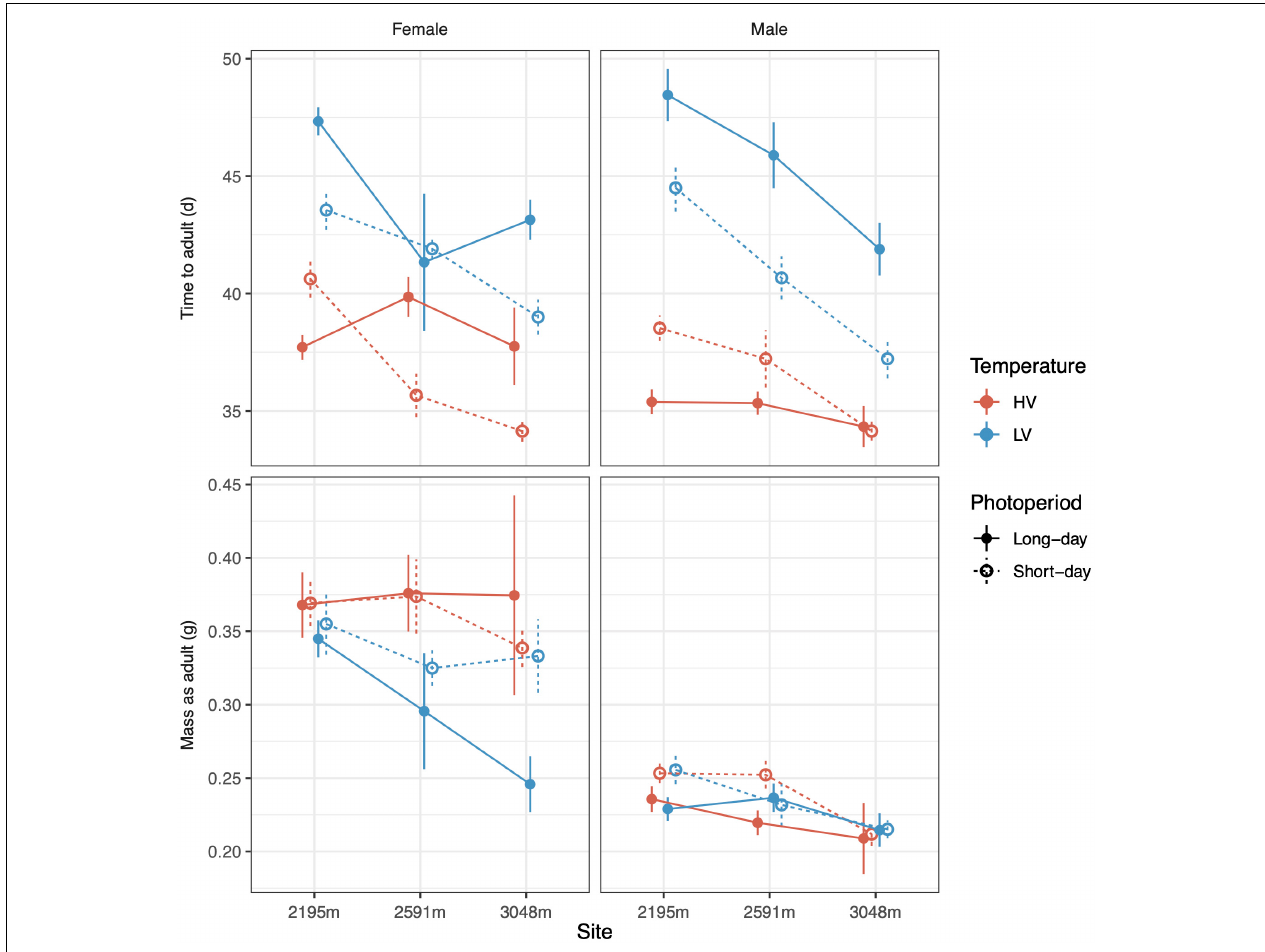
FIGURE 1 | Time to adulthood (top row) and adult mass (bottom row) vary as a function of photoperiod, temperature variance, site, and sex. High temperature variance (red color) leads to faster development, and males develop faster than females (column) across sites ( X -axis). Photoperiod (line type) interacts with temperature to determine development rates. Low temperature variance at higher elevation sites leads to lower mass, especially in females. Error bars represent standard error.